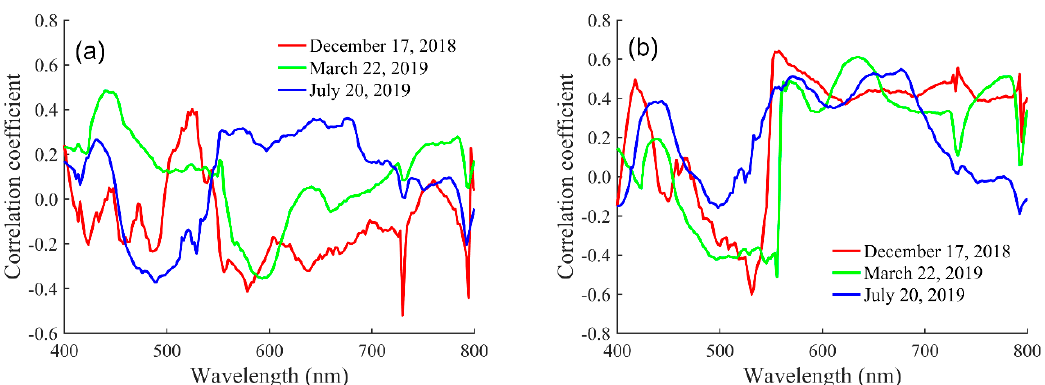
Figure 7. Pearson correlation coefficients ( a ) between normalized reflectance and Chl-a concentration; ( b ) between normalized reflectance and TSM concentration.